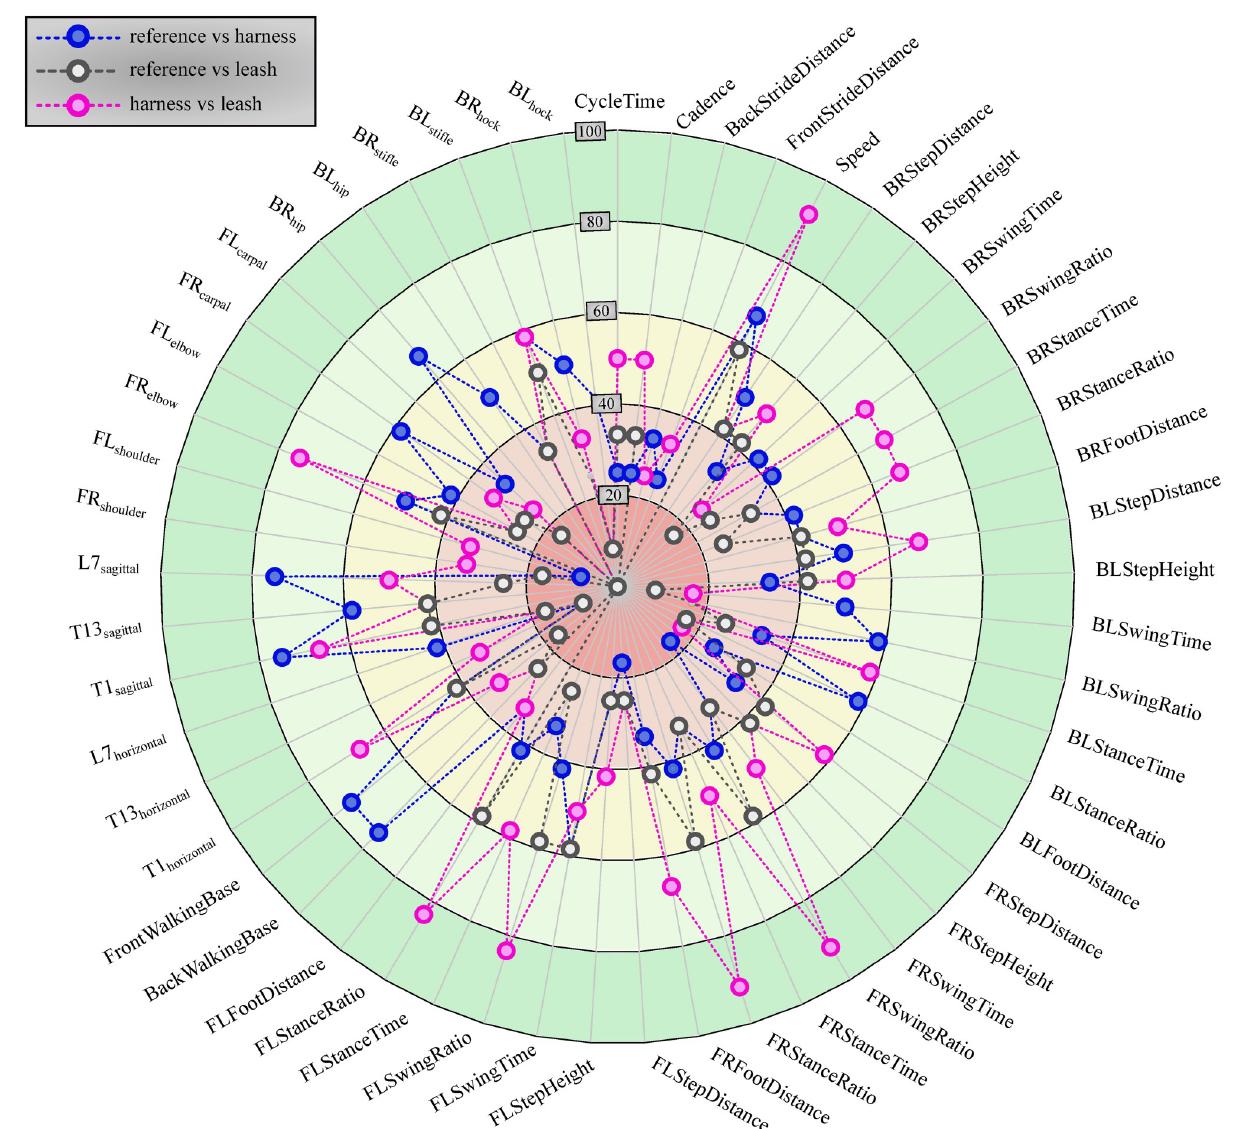
Fig 11. Result of Kolmogorov-Smirnov test for each parameter grouped according to the different configurations. Percentage of cases (indicated by the distance from the centre) a given calculated parameter (spatio-temporal or joint range of motion, as named on the edge of the circle) passed the two-sided Kolmogorov-Smirnov test for identical distributions ( p > 0.05) (12 cases for each configuration in